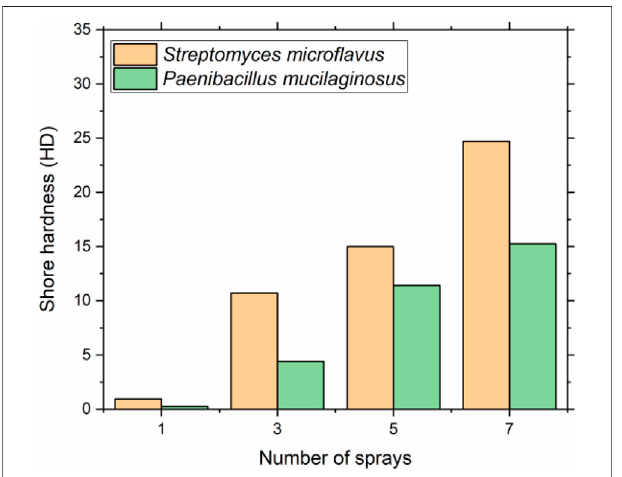
FIGURE 3 | Calcium carbonate content of consolidated sand samples prepared by spraying at different